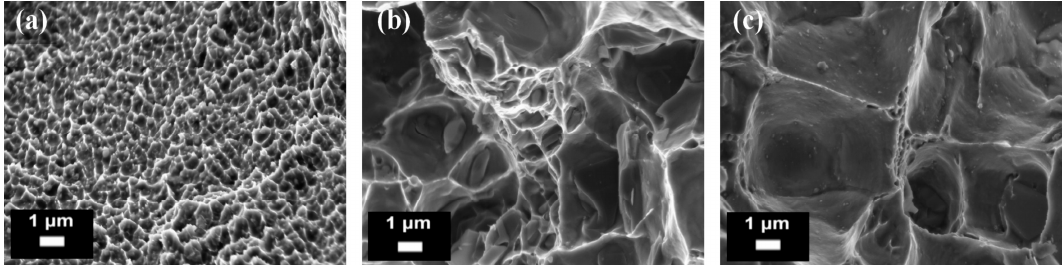
Figure 19. FESEM micrographs of fracture surfaces of AlSi10Mg samples produced by means of DMLS and heat treated: ( a ) as-built conditions; ( b ) after a T4 treatment; ( c ) after a T6 treatment (from the authors’ own unpublished work).